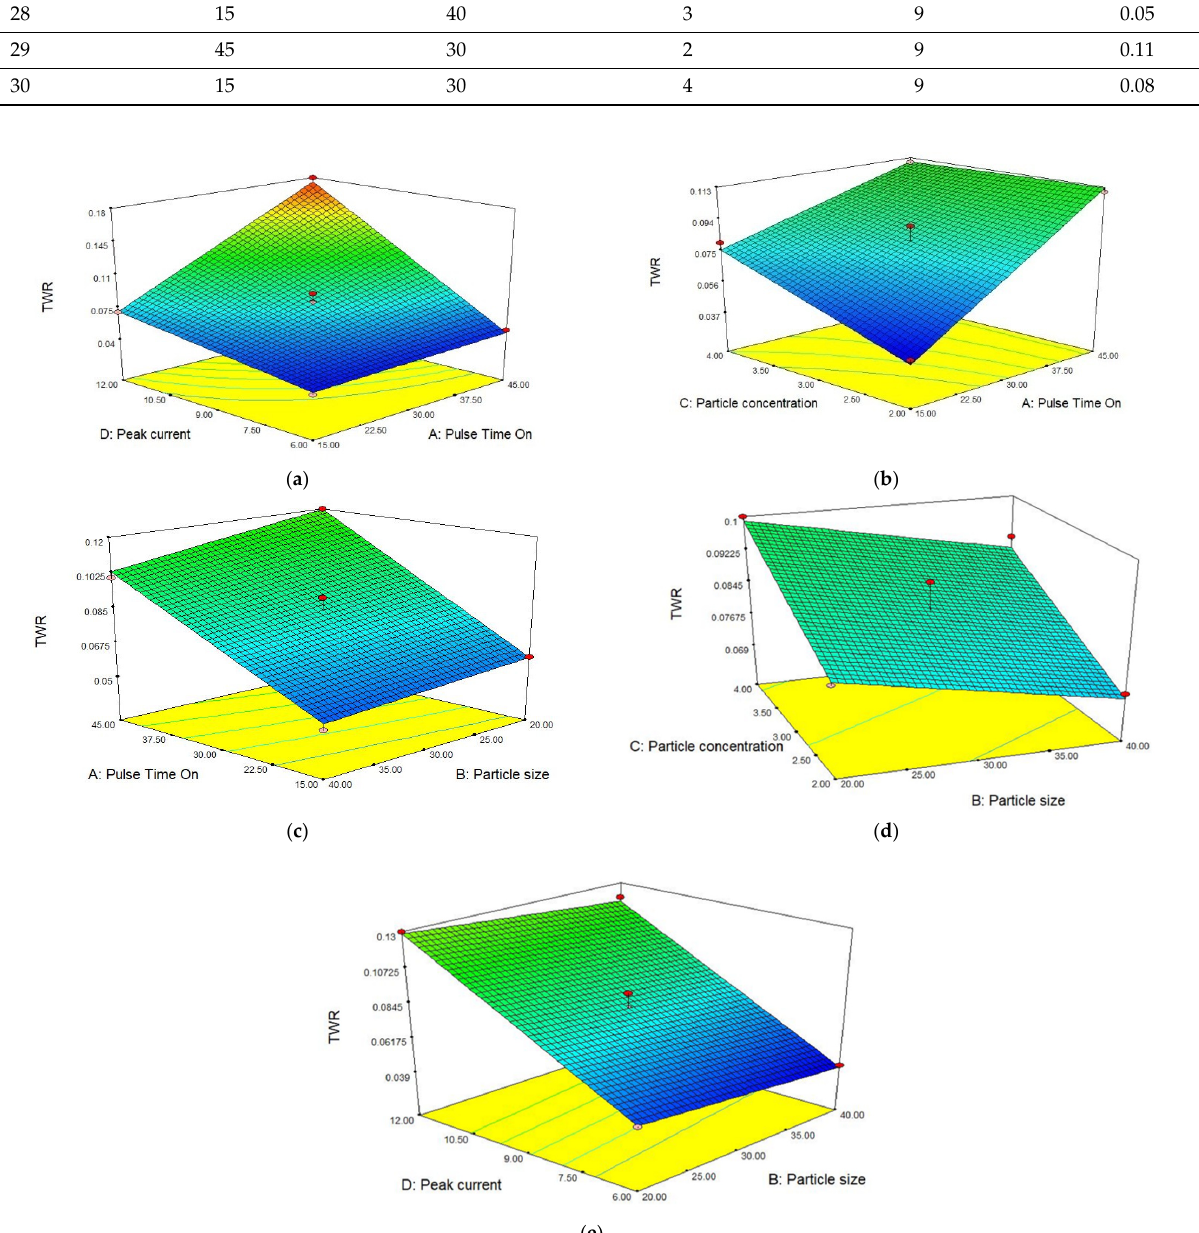
Figure 5. Effect of different parameters on TWR results. ( a ) Peak current vs. pulse time on. ( b ) Pulse time on vs. particle concentration. ( c ) Particle size vs. pulse time on. ( d ) Particle size vs. particle concentration. ( e ) Particle size vs. peak